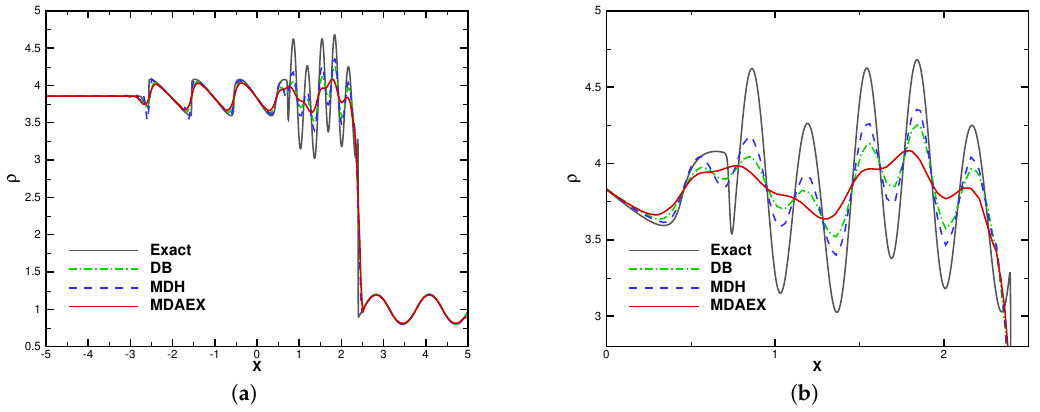
Figure 8. Density solution for the one-dimensional Shu–Osher problem with 200 elements at t = 1.8, P 1. ( a ) Overview; ( b ) zoomed in results.